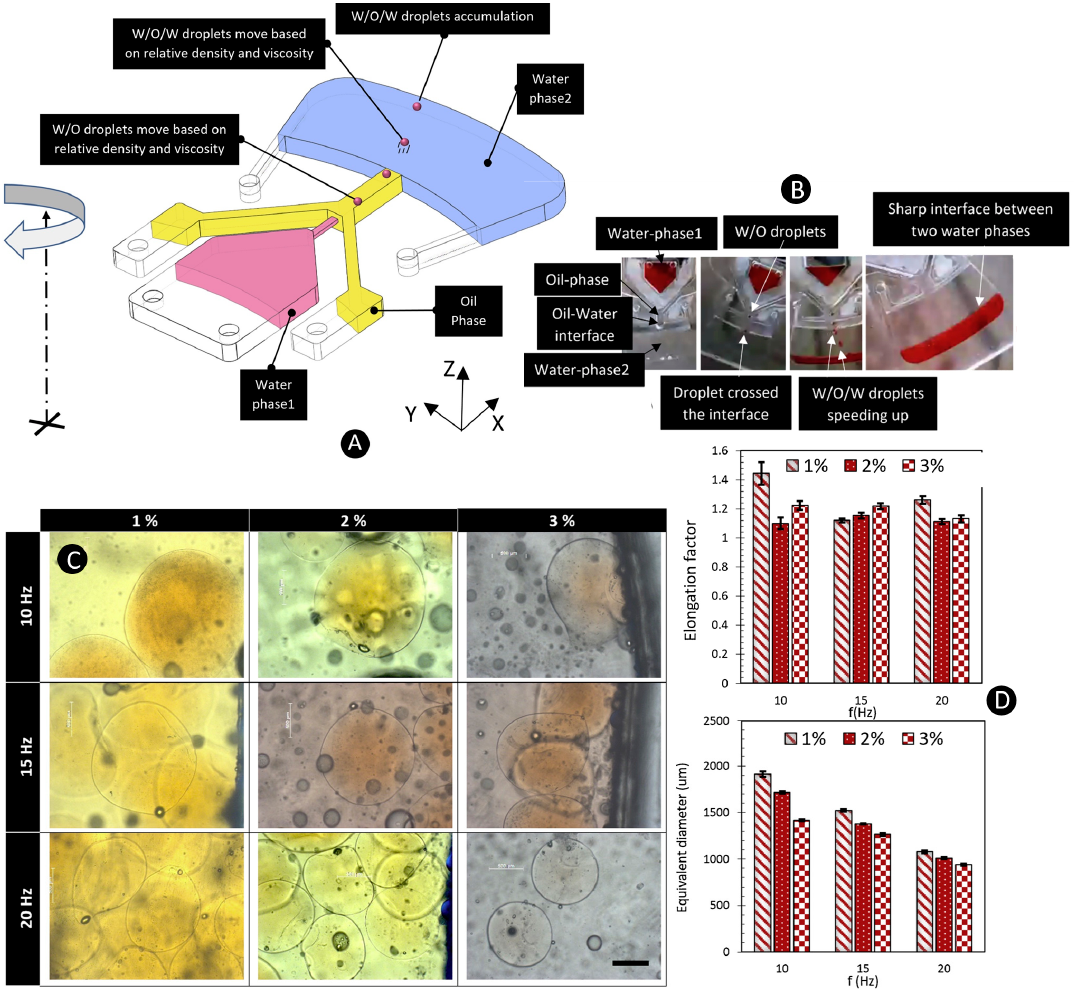
Figure 19. ( A ) The schematic of fluidic barrier concept; ( B ) The sequential images of the production of double emulsion on centrifugal microfluidics; ( C ) Microscope images of the particles using different frequencies and alginate concentrations. The scale bar is 500 µm; ( D ) Aspect ratio and diameter of the generated particles as a function of rotational frequency and alginate concentration. Reprinted with permission from [131].